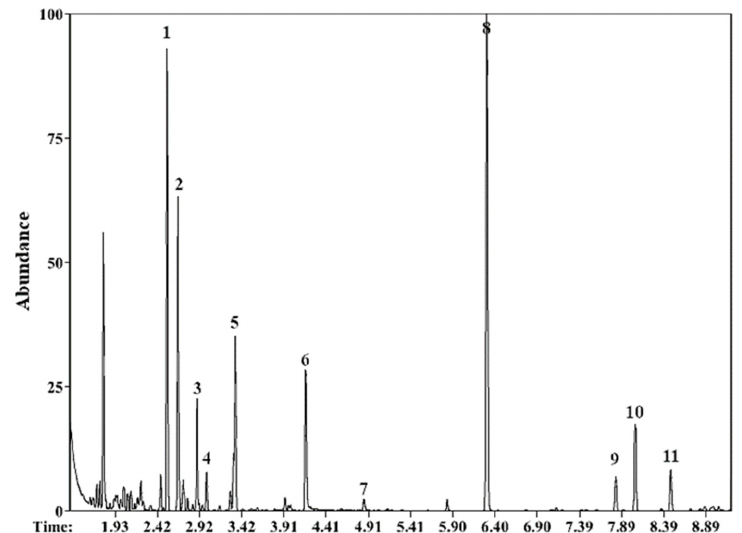
Figure 1. Sample chromatogram of fir foliar extract. Peak assignments are as follows: (1) α -pinene, (2) camphene, (3) β -pinene, (4) 3-carene, (5) D limonene, (6) maltol, (7) (-)-borneol, (8) bornyl acetate, (9) caryophyllene, (10) humulene, and (11) α -bisabolene.